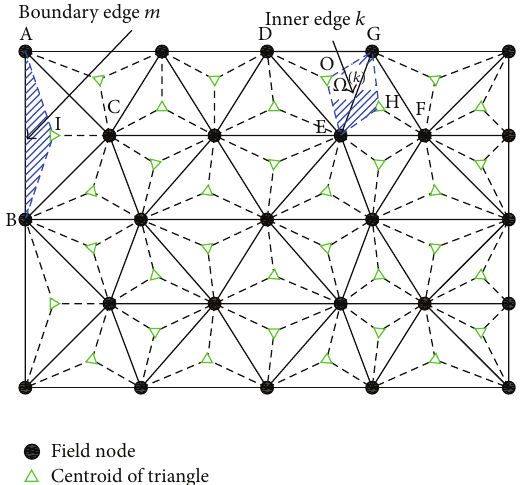
Figure 3: Construction of edge-based strain smoothing domains.